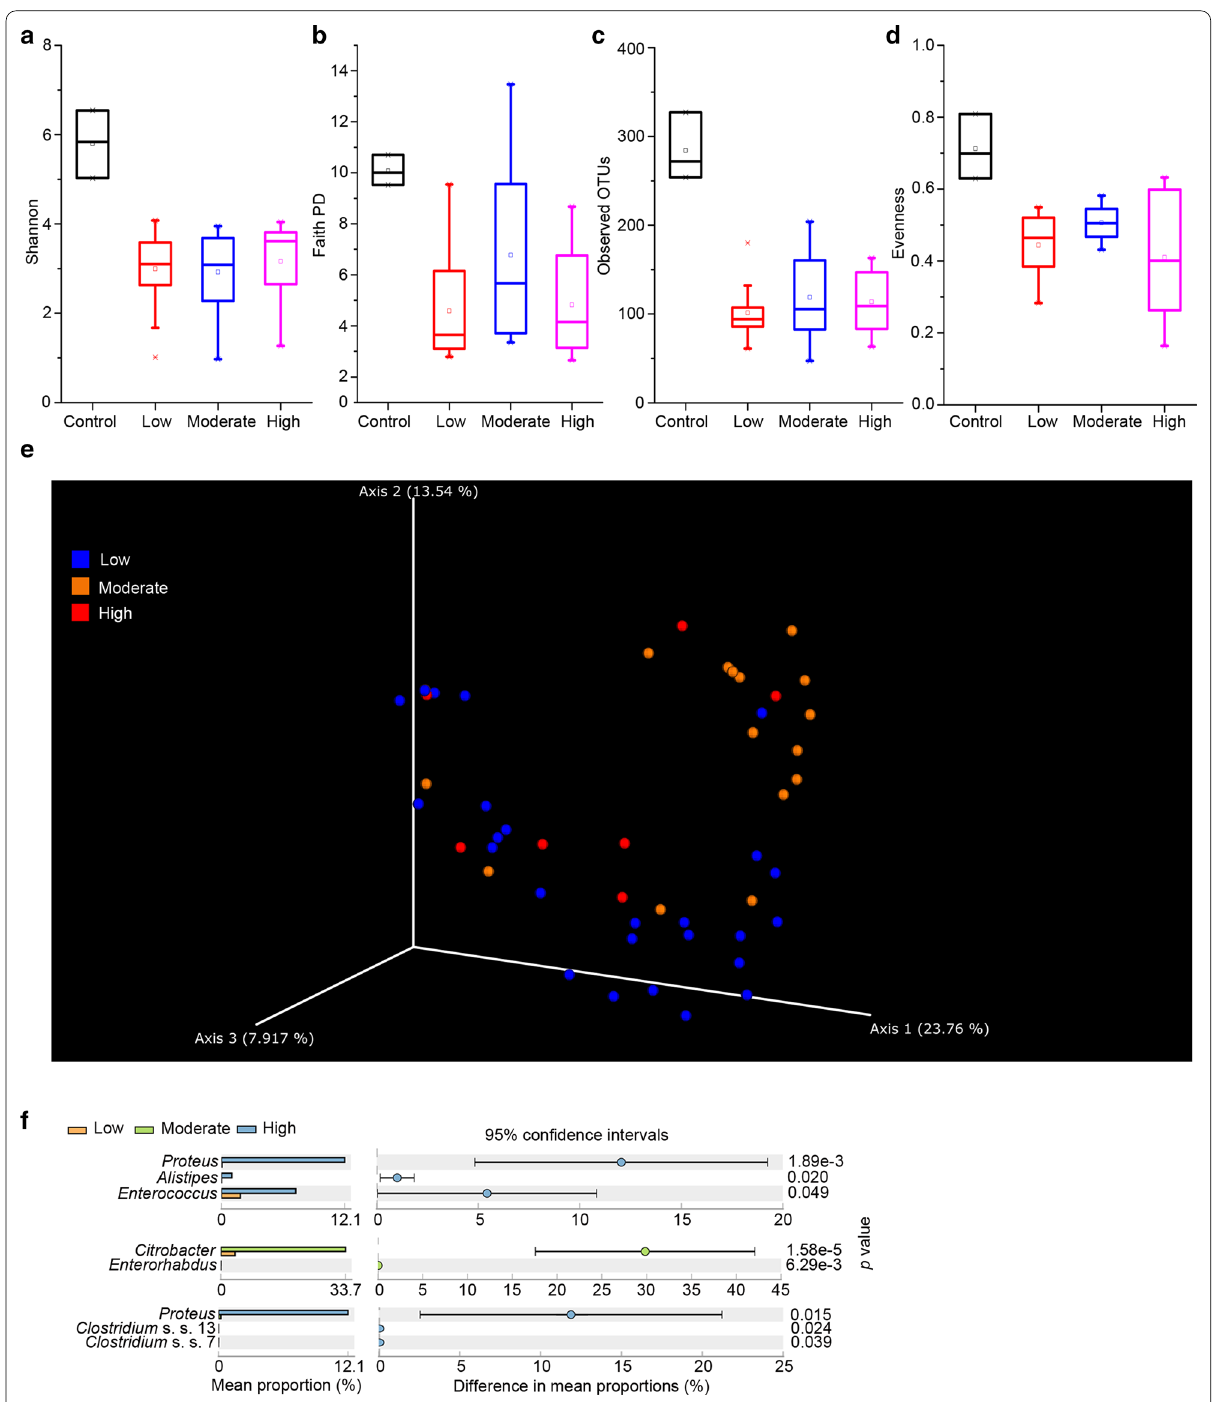
Fig. 3 Density of bacterial colony affected the diversity and composition of the fecal bacterial communities. Shannon ( a ), faith pd ( b ), observed OTUs ( c ), and evenness index ( d ) in the low-, moderate-, and high-density groups and uncultured feces. e PCoA based on bray–curtis distance of the fecal cultured communities in the low-, moderate-, and high-density group and uncultured feces. f STAMP analysis indicated the genera that were significantly different between the low-, moderate-, and high-density